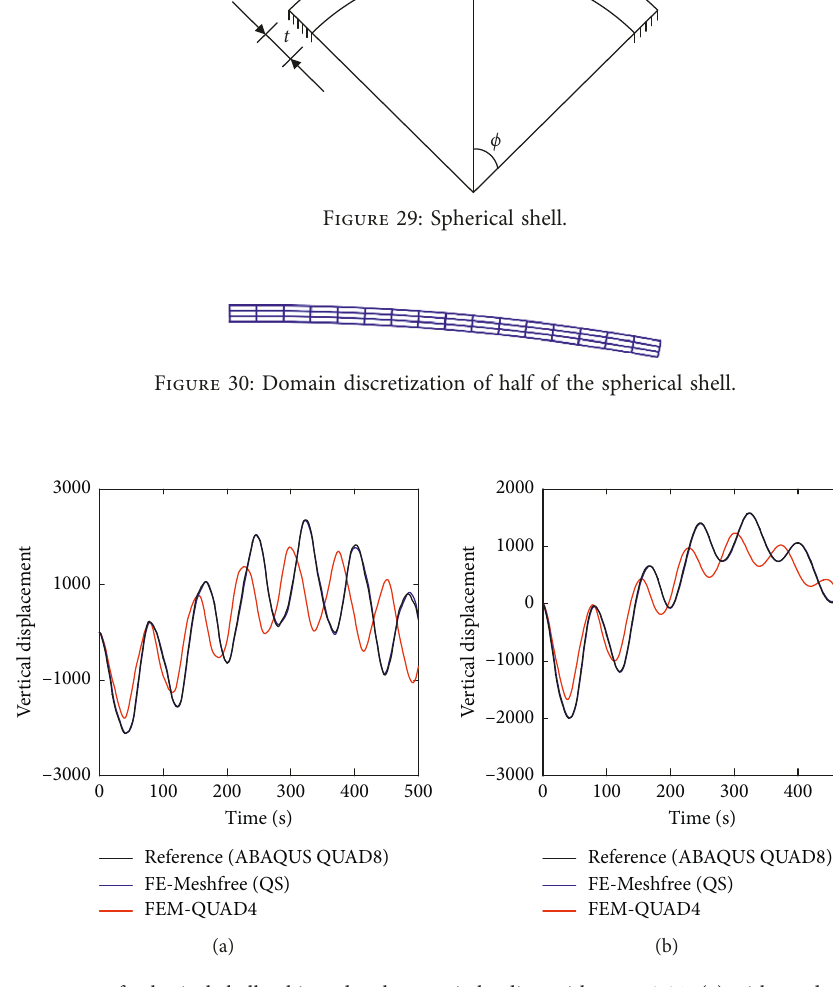
� 0 . 01: (a) without damping; (b) with damping. f